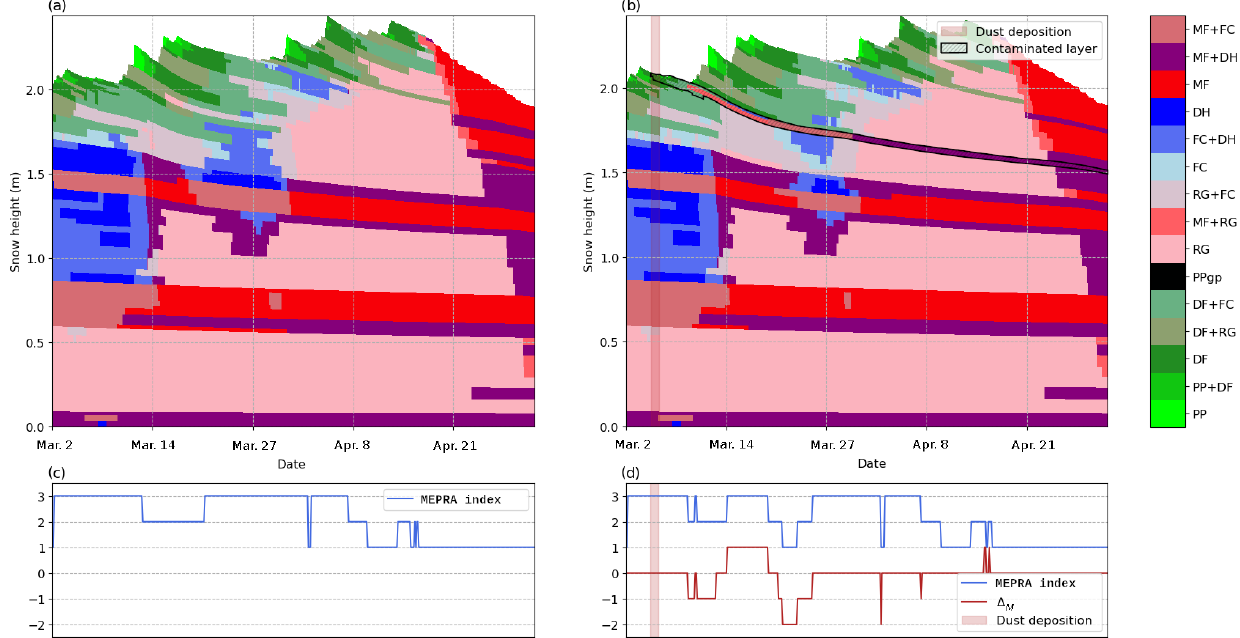
Figure 2. The upper panels show snow profiles for the same member (member 8) of the ensemble simulations on a 40 ◦ steep north-facing slope. Panel (a) refers to the no-dust simulation and (b) to the dust simulation. Snow grain shape abbreviations follow the international snow grain shape classification (Fierz et al., 2009) (Table A1), and the shading (hatches) corresponds to the layer contaminated with more than 10 − 4 gg − 1 of dust. The lower panels present the MEPRA stability indicator (in blue) for (c) no-dust and (d) dust simulations. Panel (d) also shows in red the (cid:49) M index which represents the difference in stability between